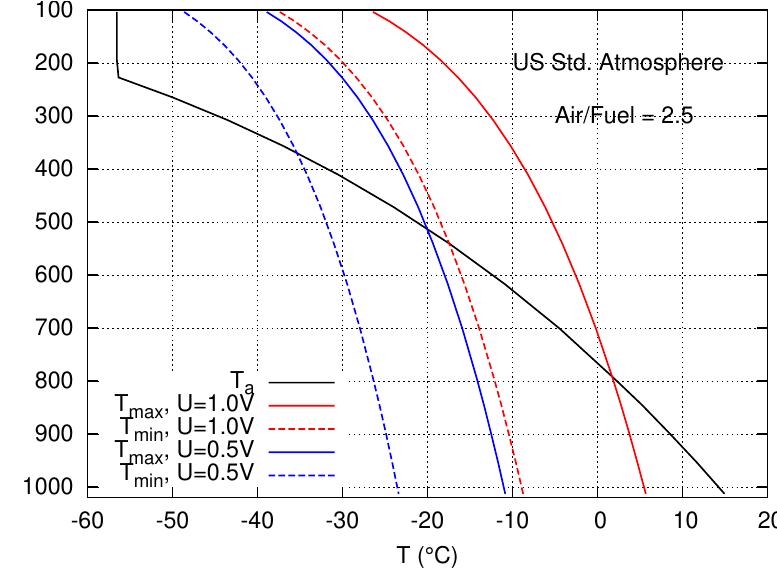
Figure 2. Profiles of temperature from the ground to about 13 km altitude, or 100hPa. The black line represents the US Standard Atmosphere. The red lines are T max (solid) and T min (dashed) for fuel cells with U = 1V. The blue lines are the analogue for U =